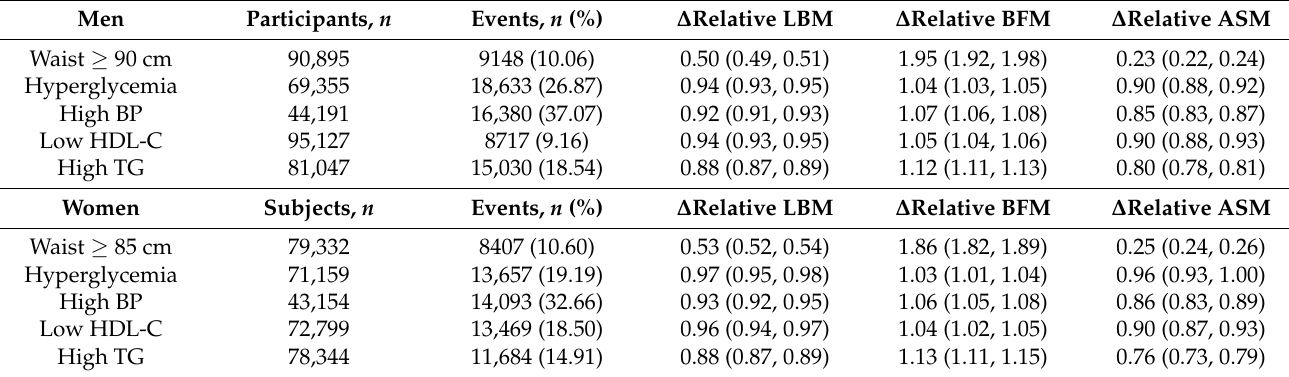
Table 4. Adjusted odds ratios and 95% confidence intervals of the newly developed metabolic paTable 1. increments) in multiple body composition parameters.